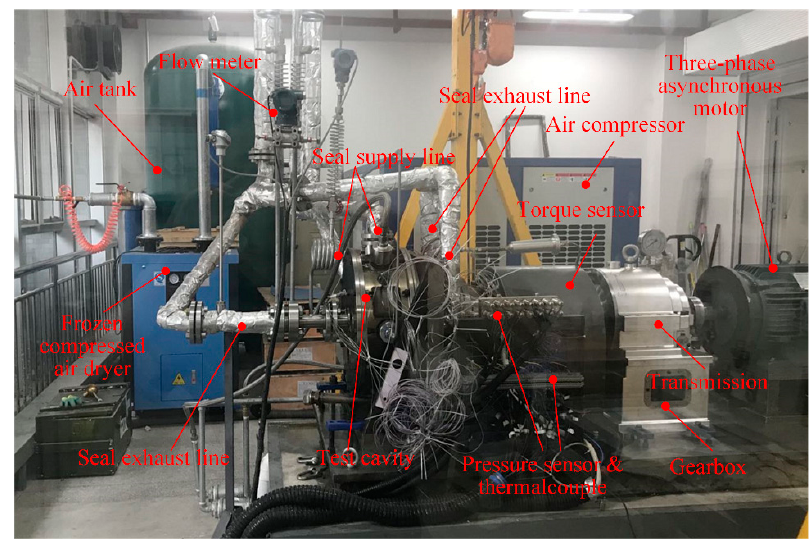
Figure 8. Photograph of the High ‐ Temperature, Ultra ‐ High ‐ Speed Sealing Test Rig.